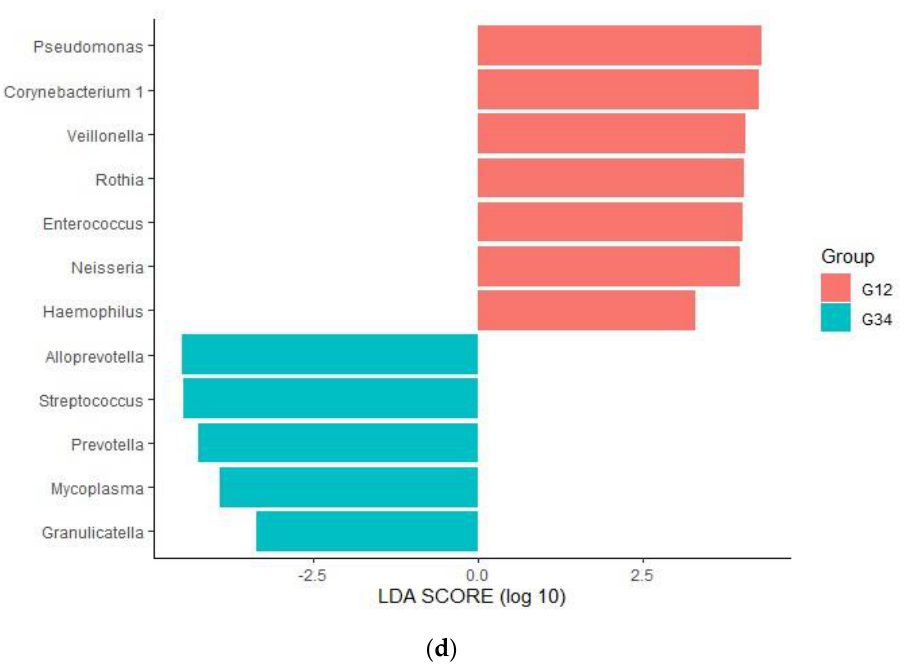
Figure 1. The respiratory microbiome differed between intubated patients with pneumonia and those without pneumonia. ( a ) Lower respiratory tract microbiome composition at phylum and genus levels. ( b ) Shannon diversity index and Simpson index. Red: pneumonia group, blue: non-pneumonia group.